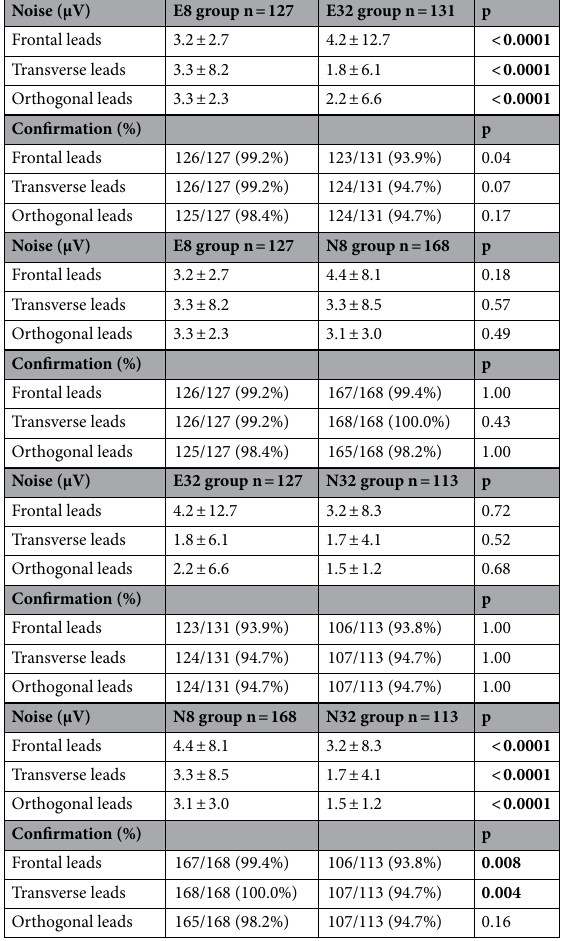
Table 3. Noise values and confirmation during the resting phase, according to set of leads in the different groups. Noise values are expressed as mean and standard deviation. Groups: E8 = Ellestad factor 1/8; E32 = Ellestad factor 1/32; N8 = Naughton factor 1/8; N32 = Naughton factor 1/32. Data presented as Mean ± Standard Error. Bold values indicate statistical significance. Significant p-value considered 0.0083 (Bonferroni’s